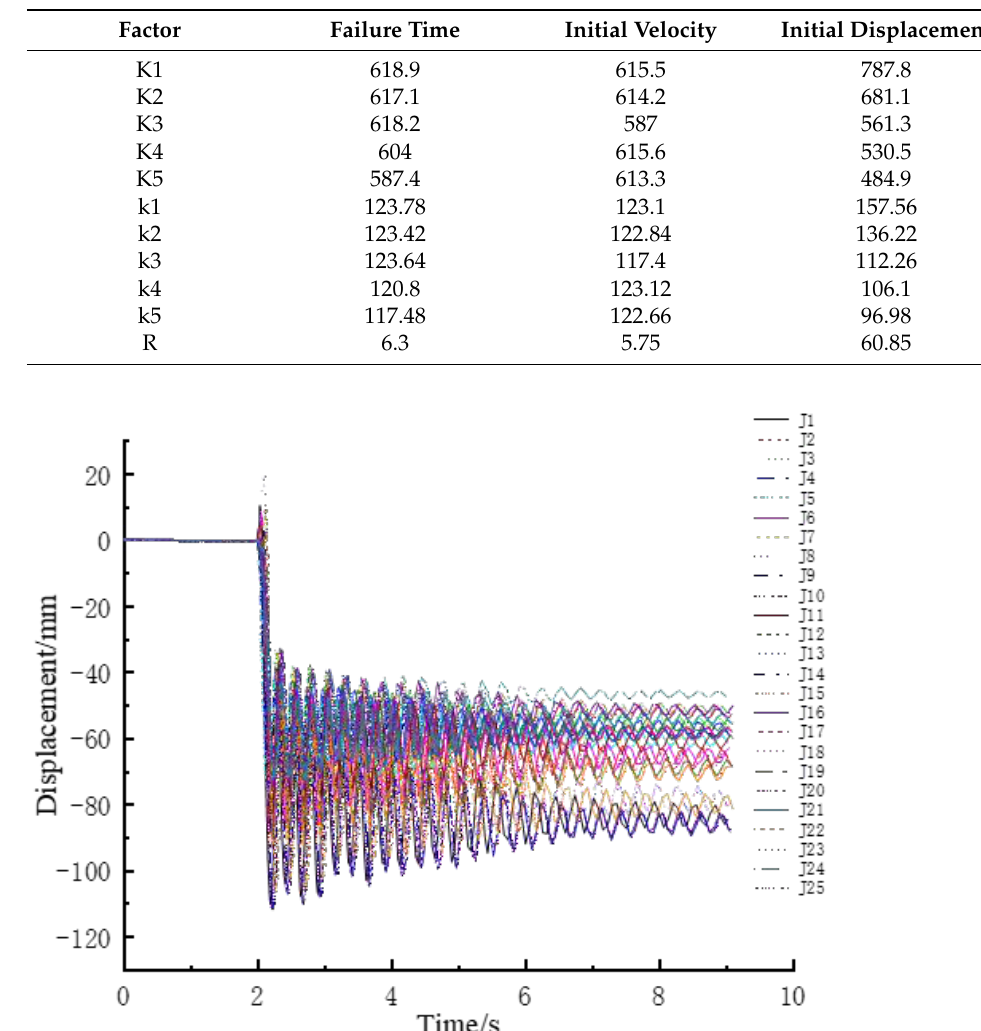
Figure 4. Vertical displacement of column top after the failure of bottom corner column .